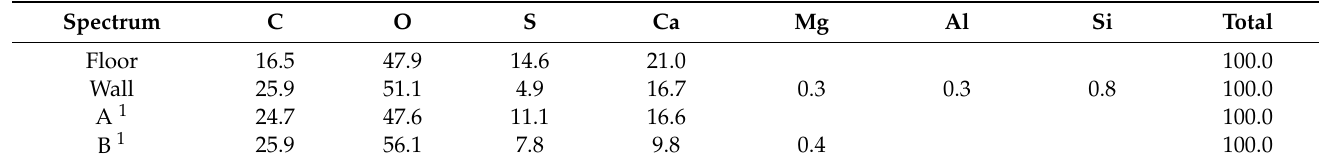
Figure 4. SEM micrographs of the samples collected from pavimental mosaic ( a , b ) and from the wall ( c , d ). Table 1. EDS analysis (% w/w ) of the wall and floor samples.